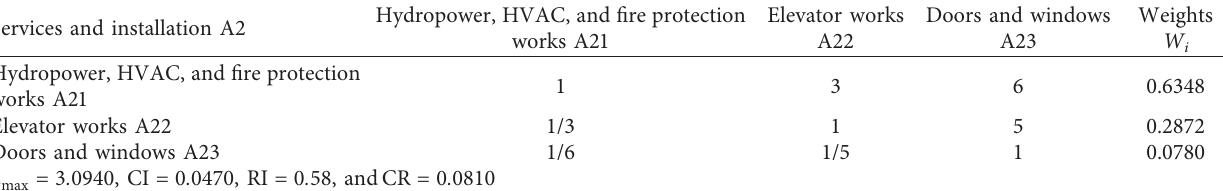
Table 6: The weight calculation matrix for services and installation works (A2).